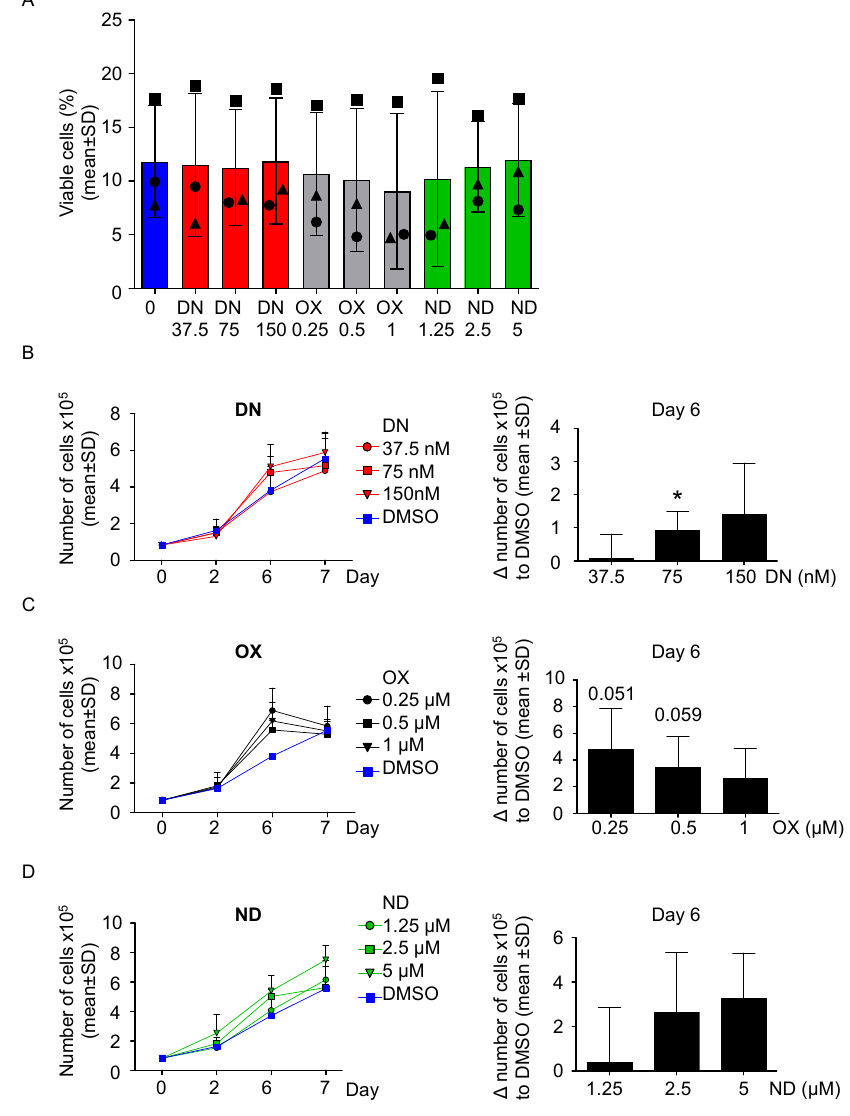
Figure 2. All ADs increase the number of cells DKC-derived PBMCs in vitro in a comparable fashion. ( A ) PBMC were treated for up to 9 days with three increasing concentrations of danazol (37.5 nM, 75 nM and 150 nM), oxymetholone (OX, 0.25 µ M, 0.5 µ M and 1 µ M), as well as nandrolone (ND, 1.25 µ M, 2.5 µ M and 5 µ M). At day 9, viability was determined by PI staining and analysis via fluorescence-activated cell sorting (FACS). Patient #1 is represented with a circle, Patient #2 with a triangle and patient #3 with a square. ( B ) PBMC were treated with danazol, as described in panel A. The number of cells was assessed versus the vehicle control (DMSO) at day 0, 2, 6, and 7. On the left, growth curves for each condition are shown. On the right, the di ff erence between each treated condition and DMSO was calculated and shown into a bar graph. One sample t -test was used to determine statistical significance. ( C ) The experiment of panel B was also performed using the three concentrations of oxymetholone (OX, 0.25 µ M, 0.5 µ M and 1 µ M). ( D ) The experiment of panel B was also performed using the three concentrations of nandrolone (ND, 1.25 µ M, 2.5 µ M and 5 µ M). * p < 0.05.